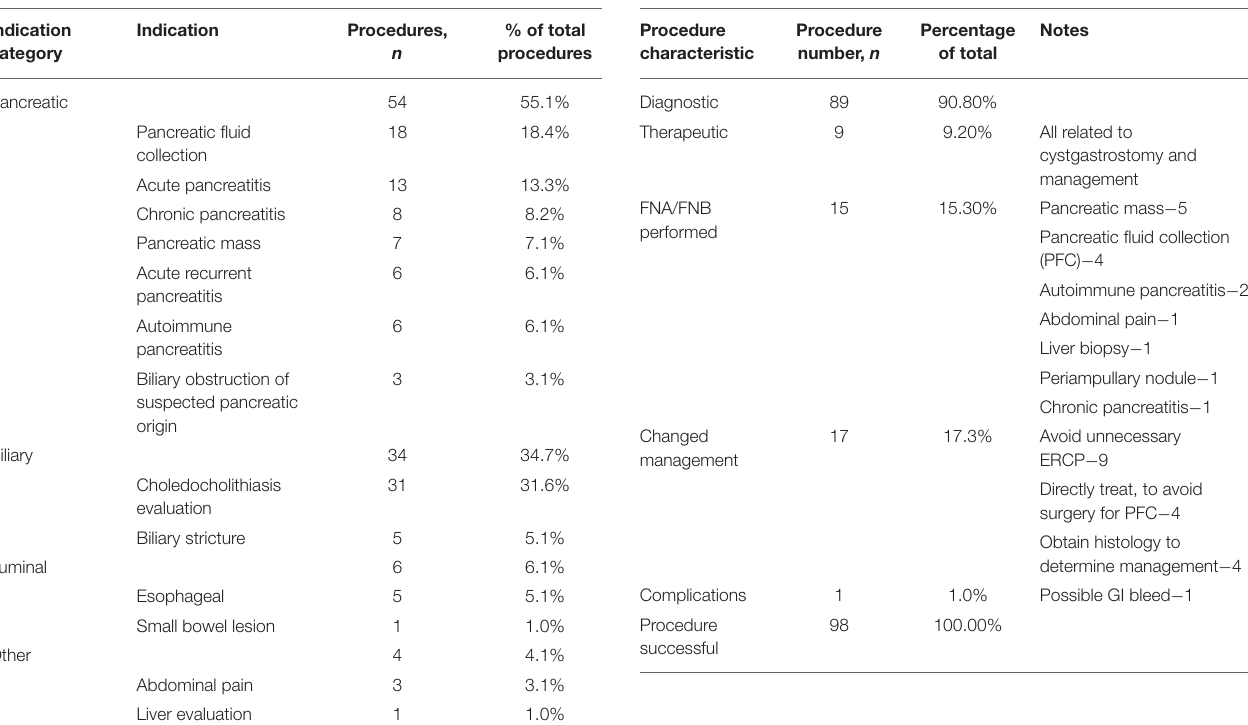
TABLE 1 | Procedure indications. TABLE 2 | Procedural